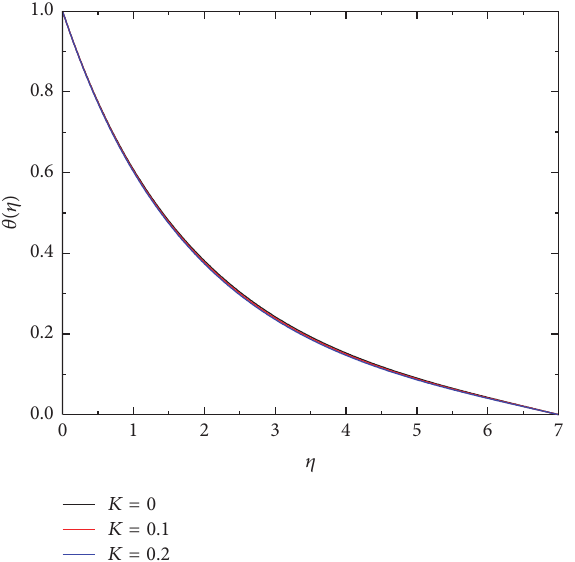
Figure 9: Velocity profiles for various values of 𝐴 when 𝐾 = 0.2 , 𝑅 = 0.5 , and 𝜉 = 0